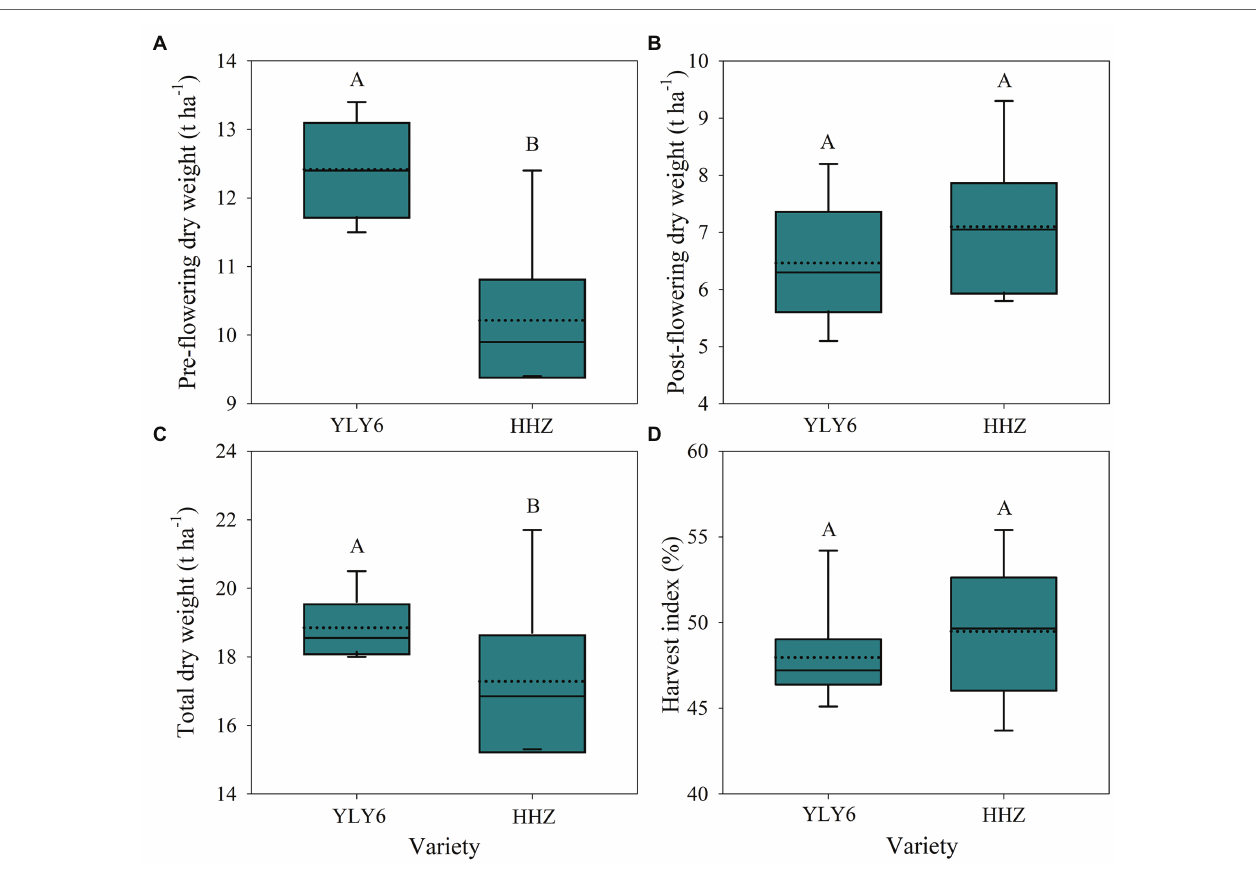
FIGURE 4 | Dry weight before flowering (A) , dry weight after flowering (B) , total dry weight at maturity (C) , and harvest index (D) for YLY6 and HHZ in Hubei Province, China, from 2012 to 2017. The box–whisker diagrams show the maximum (top of the vertical line), the 75th percentile (top of the box), the median (horizontal line within the box), the average (dotted lines within the box), the 25th percentile (bottom of the box), and the minimum (bottom of the vertical line) values ( n = 6). The different letters represent means that are significantly different at the 0.05 probability level according to LSD.